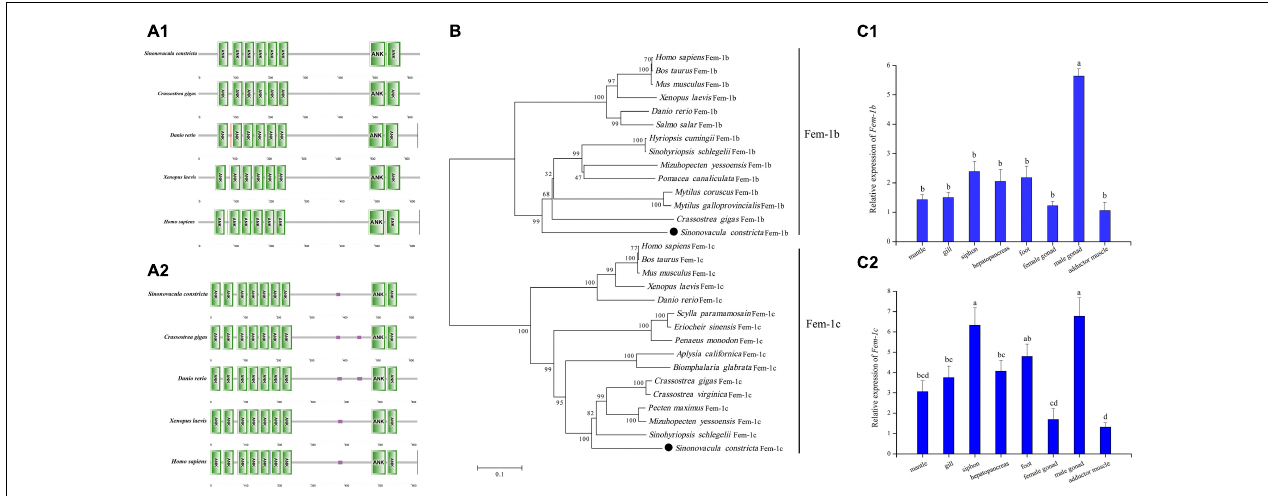
FIGURE 9 | Sequence analysis of ScFem-1b and ScFem-1c and their expression profile in adult tissues with standard deviation as error bars ( n = 3). Domain analysis of ScFem-1b (A1) and ScFem-1c (A2) with that of other model species. The phylogenetic tree of Fem-1b and Fem-1c proteins (B) . Expression profile of ScFem-1b (C1) and ScFem-1c (C2) in adult